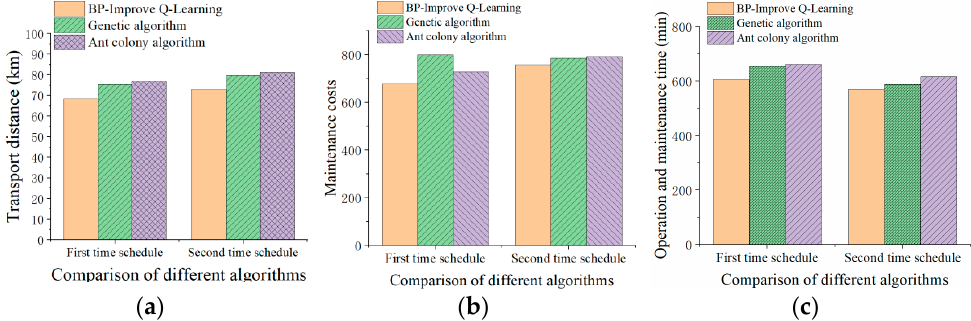
Figure 9. Comparison of optimization performance of maintenance objectives of different algorithms. ( a ) Solved transport distance comparison. ( b ) Solved maintenance cost comparison. ( c ) Solved repair time comparison.